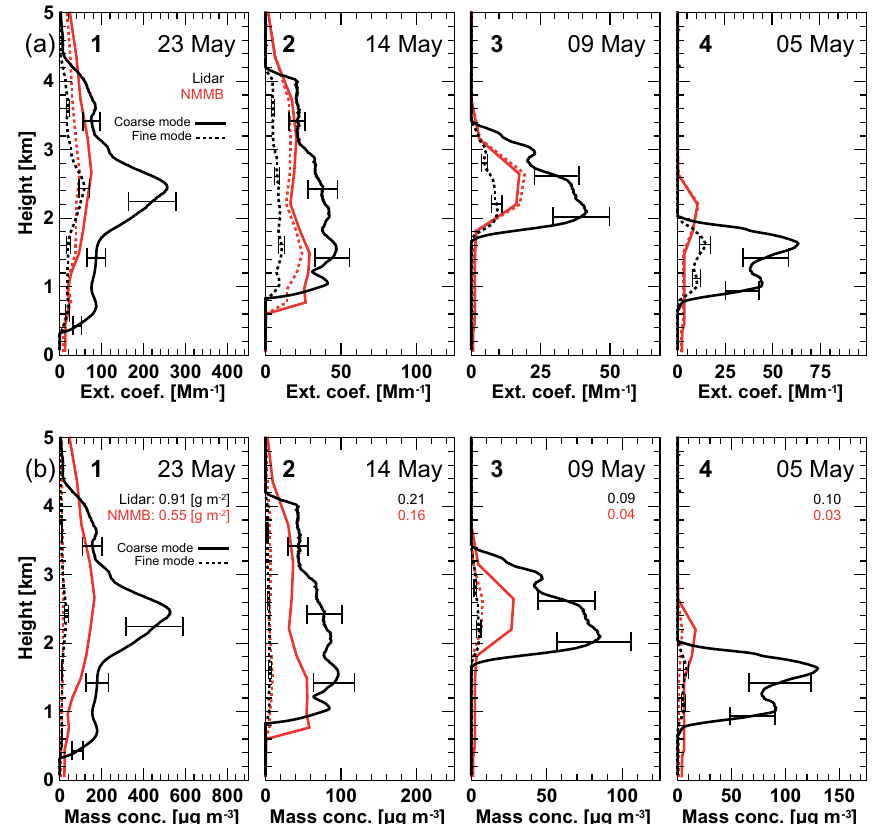
Figure 7. (a) Comparison fine (dotted) and coarse (solid) dust extinction coefficients derived from lidar observations (black) and simulated with NMMB/BSC-Dust (red). (b) Respective fine (dotted) and coarse (solid) dust mass concentrations derived from the lidar measurements (black) and simulated with NMMB/BSC-Dust (red). Column-integrated total dust mass concentrations are given as